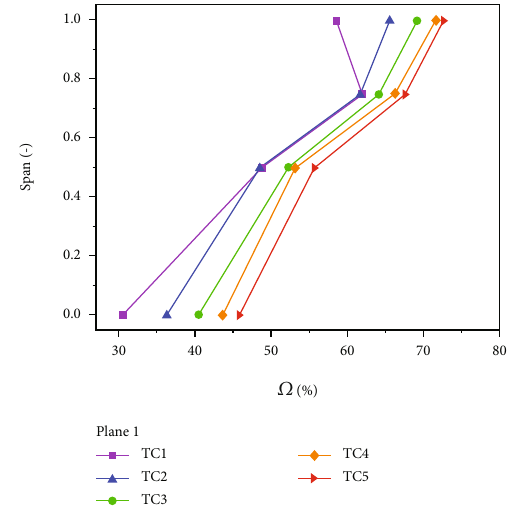
Figure 5: Reaction degree distribution for di ff erent φ